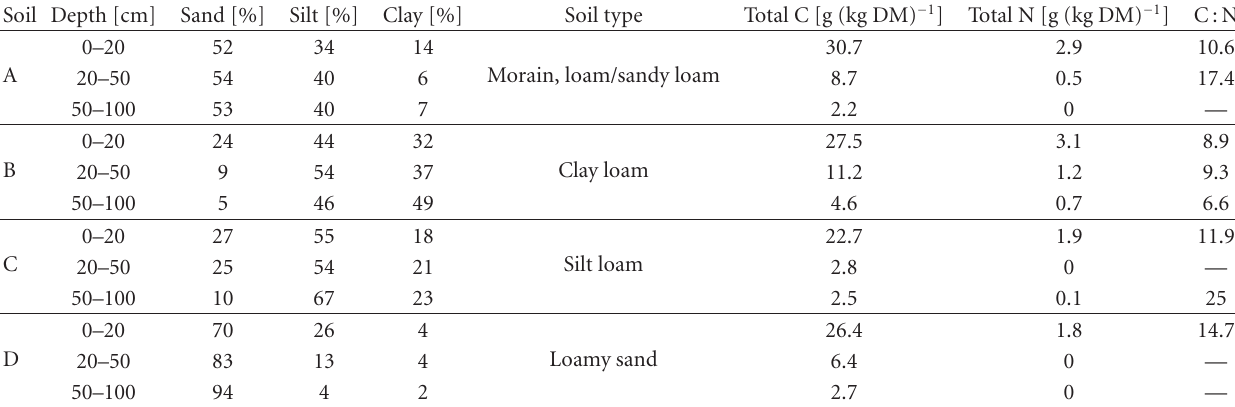
Table 2: Texture and content of C and N [g (kg DM) − 1 ] in the di ff erent types of soil included in the lysimeter experiment.